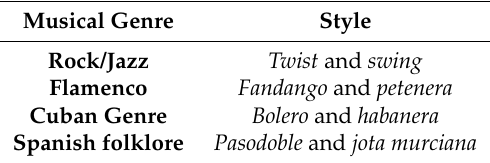
Table 1. Musical genres and styles used in the